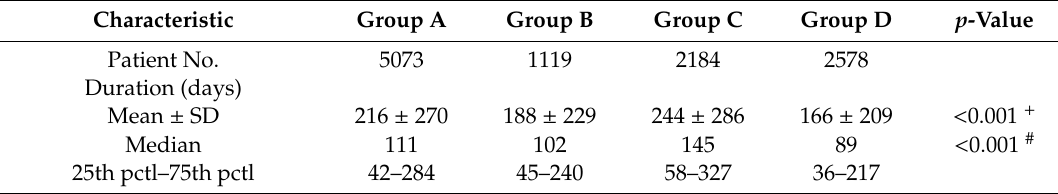
Table 2. Comparison of the predialysis duration between di ff erent treatment groups.